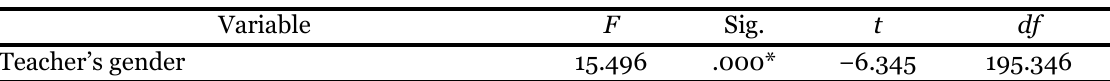
Independent Samples t Test Results of Parents’ Perceptions Toward the Distance Learning Process According to Teacher’s Gender Variable Variable